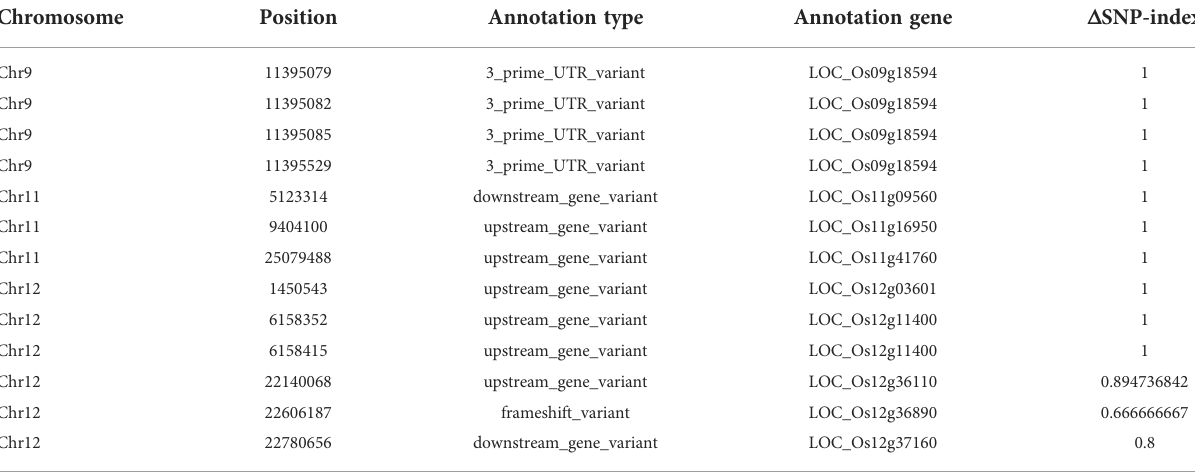
TABLE 1 Summary of candidate genes containing SNPs with D SNP-index>0.6 on genomic region of chromosomes.